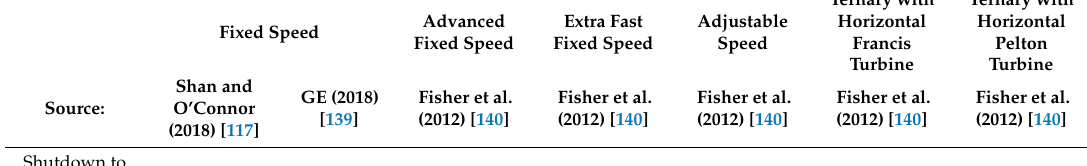
Table 27. Ramping ability of PSH plants by technology type.